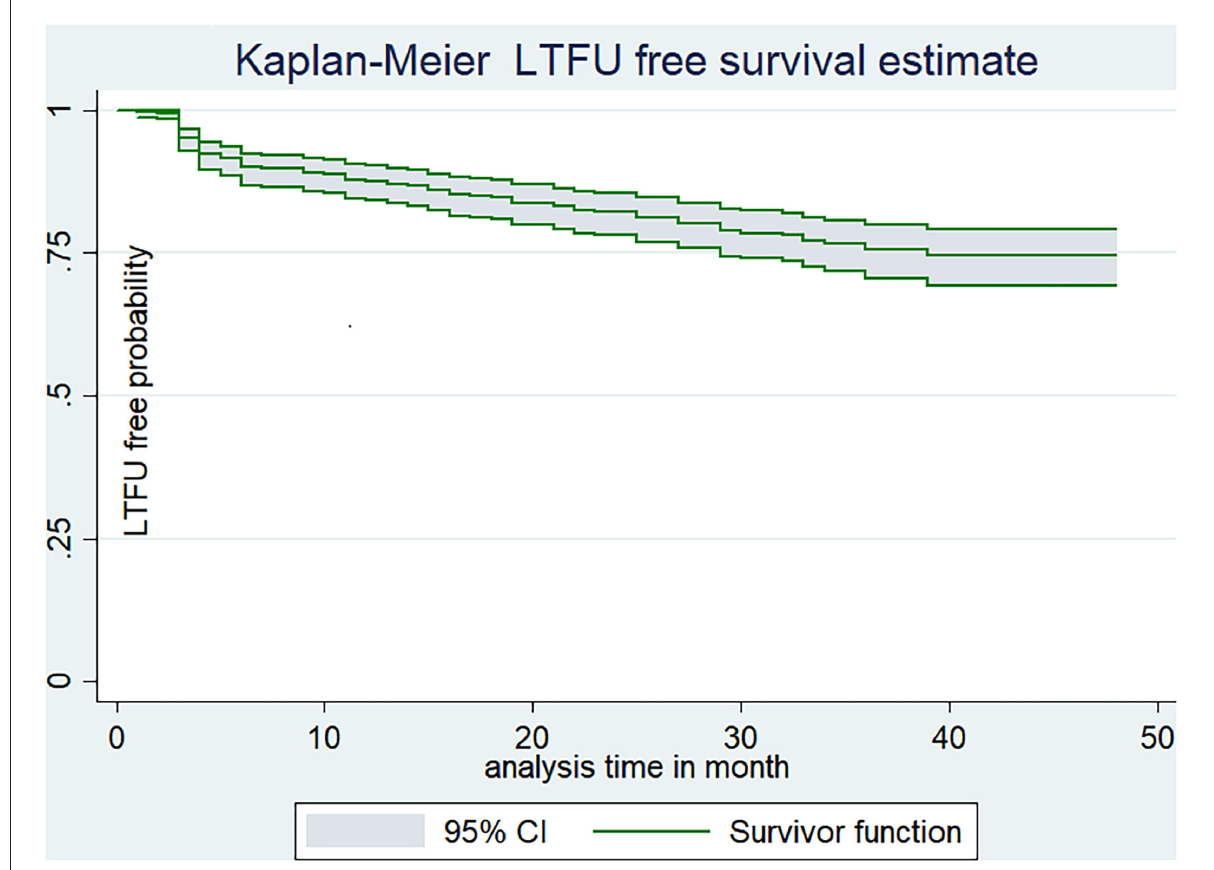
FIGURE2 Kaplan-Meier estimate of LTFU-free estimate among adults receiving ART in FHCSH, Northwest Ethiopia,